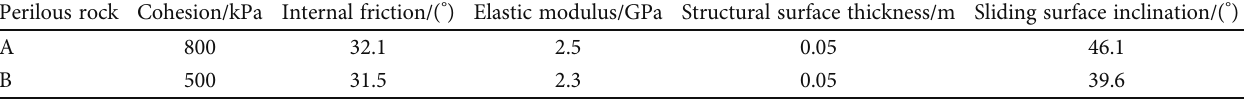
Table 2: Parameter values.